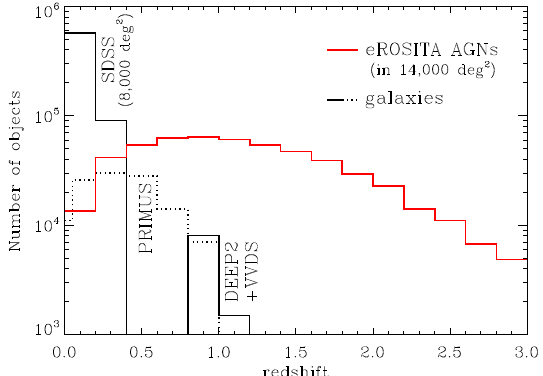
Figure 3: Number of expected eROSITA AGNs (red) and currently available galaxies with spectroscopic red- shifts (black solid line at z < 0 . 4 – SDSS data re- lease 7; black dotted line – PRIMUS (Coil et al. 2011); black solid line at z ∼ 1 – DEEP2 (Davis et al. 2003) and VVDS (Le F`evre et al.